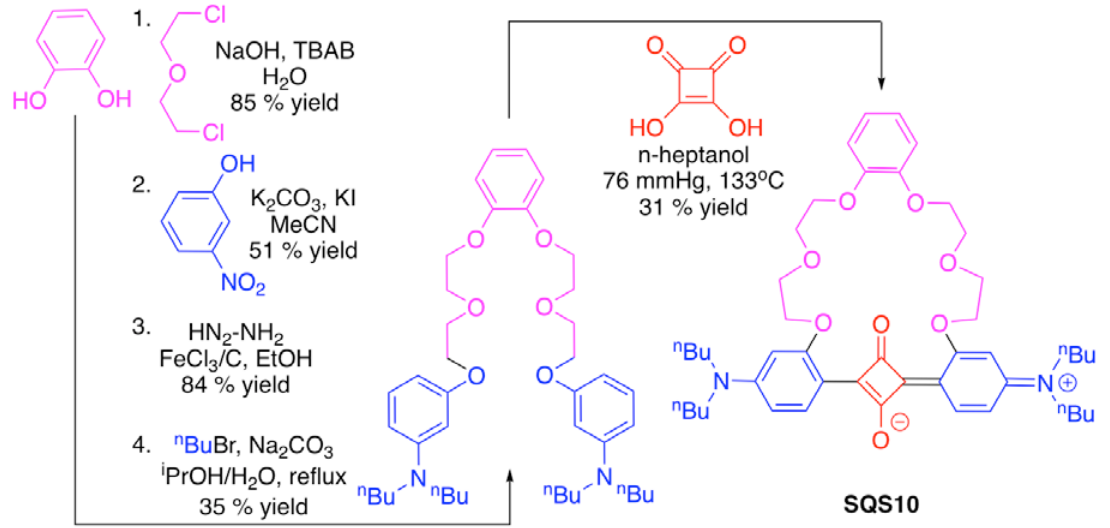
Scheme 7. Synthesis of Pb 2+ -specific SQS10